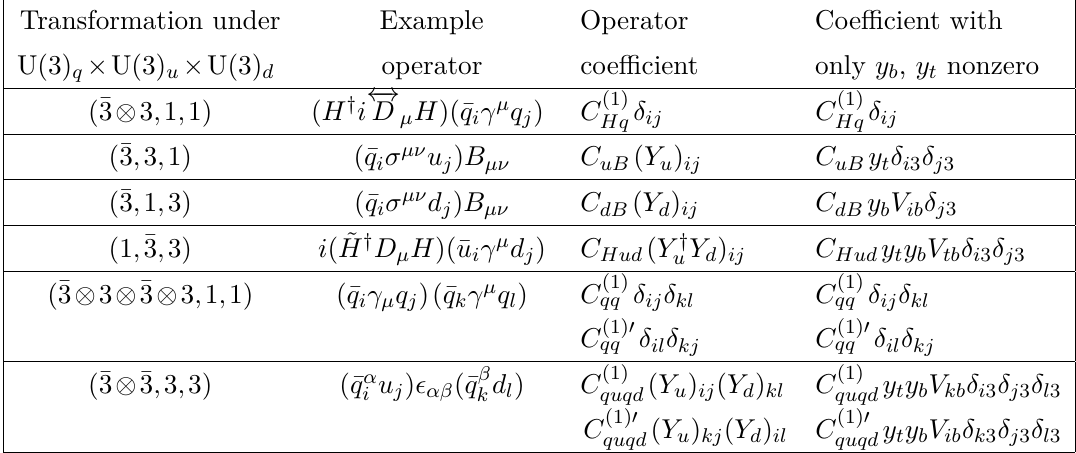
Table 1. Structure of Lagrangian coefficients for operators with quark flavour indices. The coeffi- cients in the final column are given in the flavour basis defined by eqs. (2.5) and (2.6). All columns apart from the last are flavour-basis-independent (if no assumptions are made about the diagonality of the Yukawa